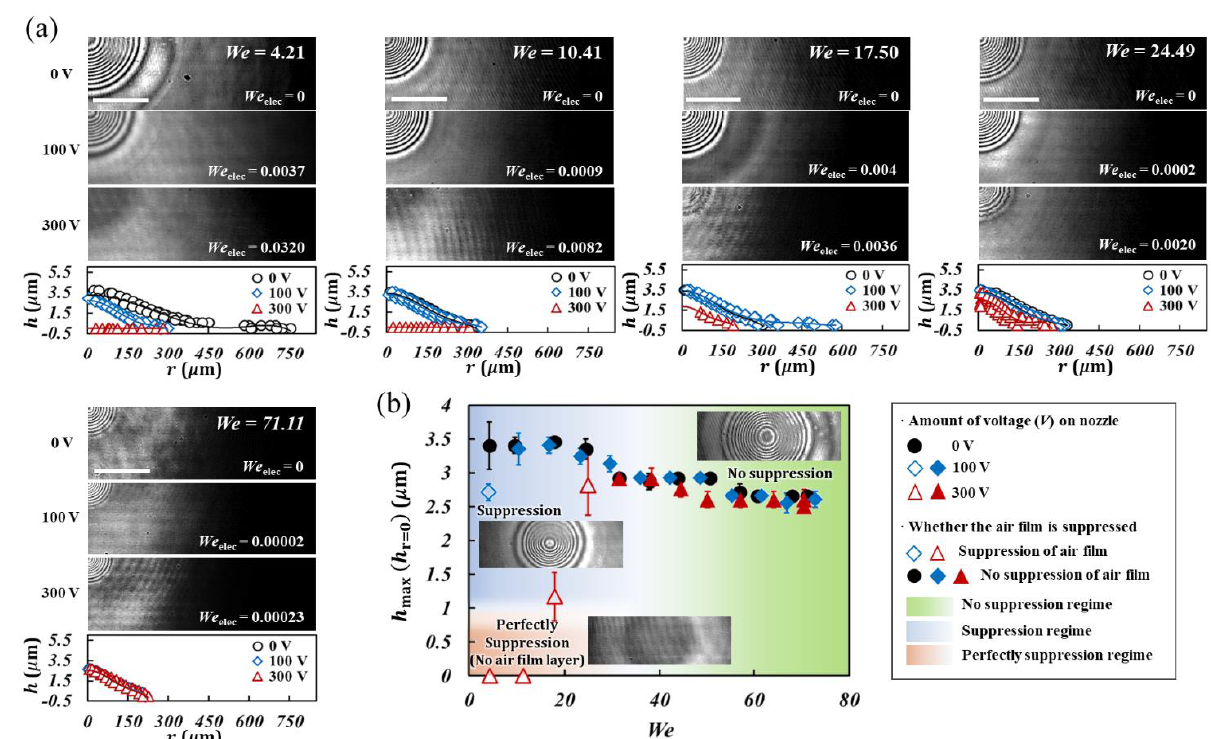
Figure 5. Suppression of the air film layer (or the dimple) for an electrified ethanol droplet under the electric field with respect to various Weber numbers ( 𝑊𝑒 ). ( a ) Snapshots of interferometry observed at the bottom and their corresponding film profiles depending on the amount of applying voltage on each dripping height. (scale bar: 300 µ m) The observed film is the maximum film profile ( ℎ max = ℎ(𝑟, 𝑡 first ) ) which we observed at the beginning of coalescence. ( b ) The maximum film thickness ( ℎ max = ℎ(0, 𝑡 first ) ) for ethanol droplets based on the Weber number ( 𝑊𝑒 ).